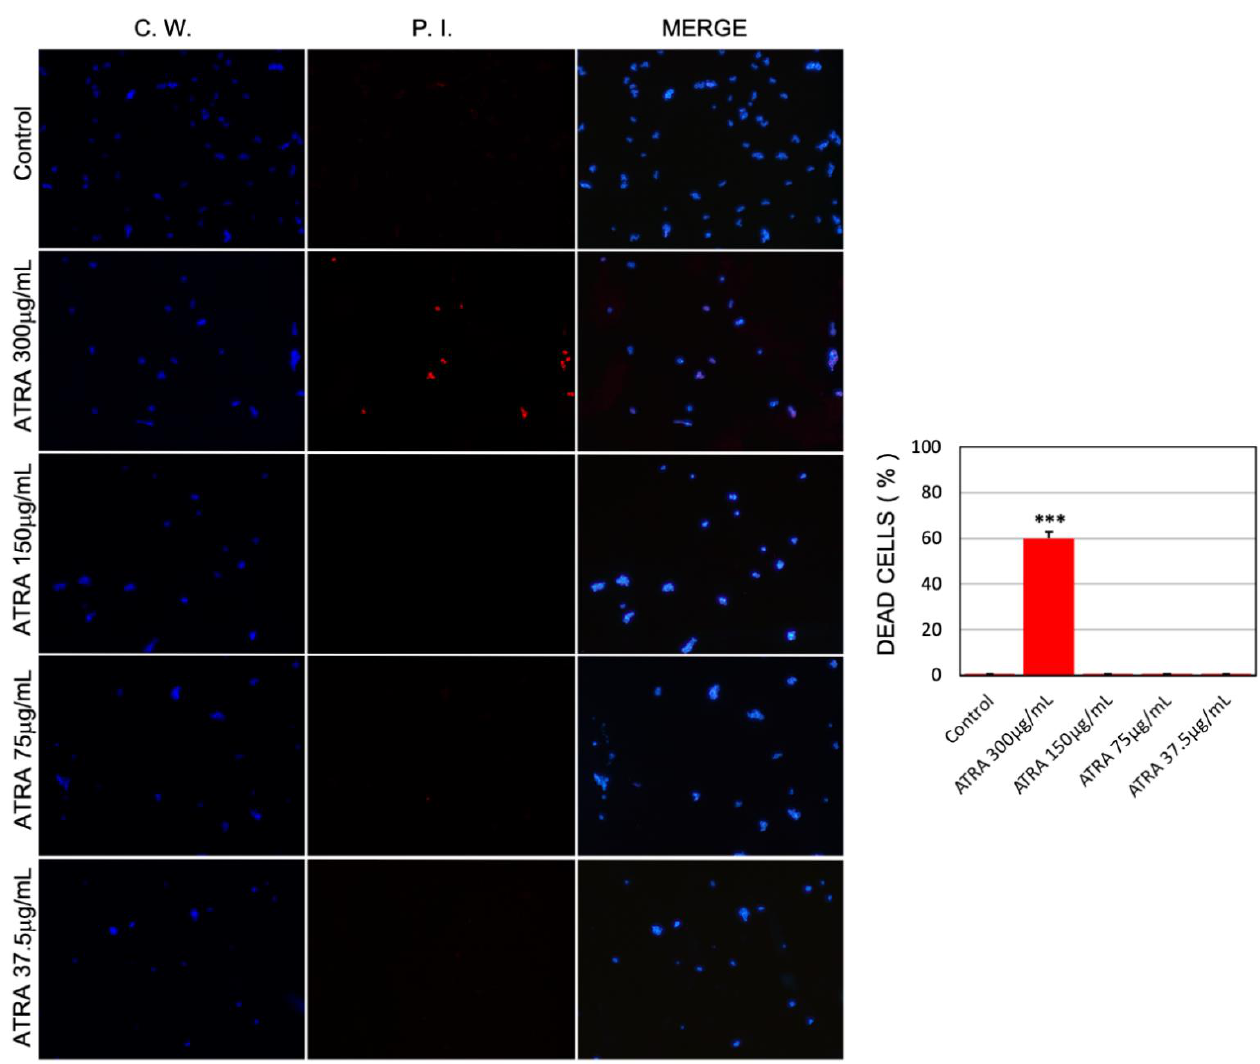
Figure 3. Visualization of C. albicans vitality by Calcofluor White (CW) and propidium iodide (PI) double staining. C. albicans planktonic cells were incubated without or with ATRA at various concentrations (300–37.5 µg/mL) for 24 h and then double-stained with CW and PI. Fluorescent images of the cells are shown. First column: Blue fluorescence represents the cell wall stained by CW; Second column: Red fluorescence represents PI-stained nucleic acids of dead cells; Last column: Merged images showing cells labeled with CW + PI. All images were obtained at 50× magnification by using a fluorescence microscope. The results are presented in histogram format as percentage of dead cells. At least 10 fields were counted per slide. *** p value <0.001.